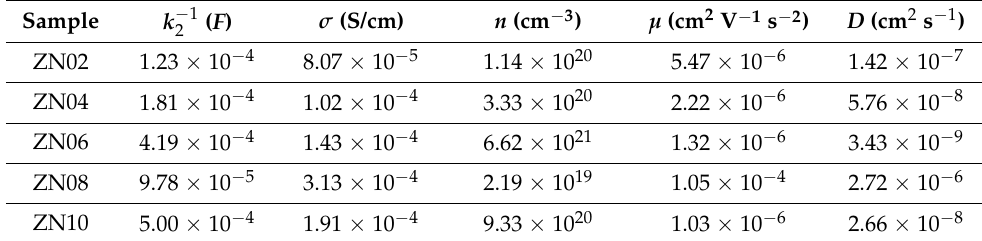
, D , µ and n for prepared 2